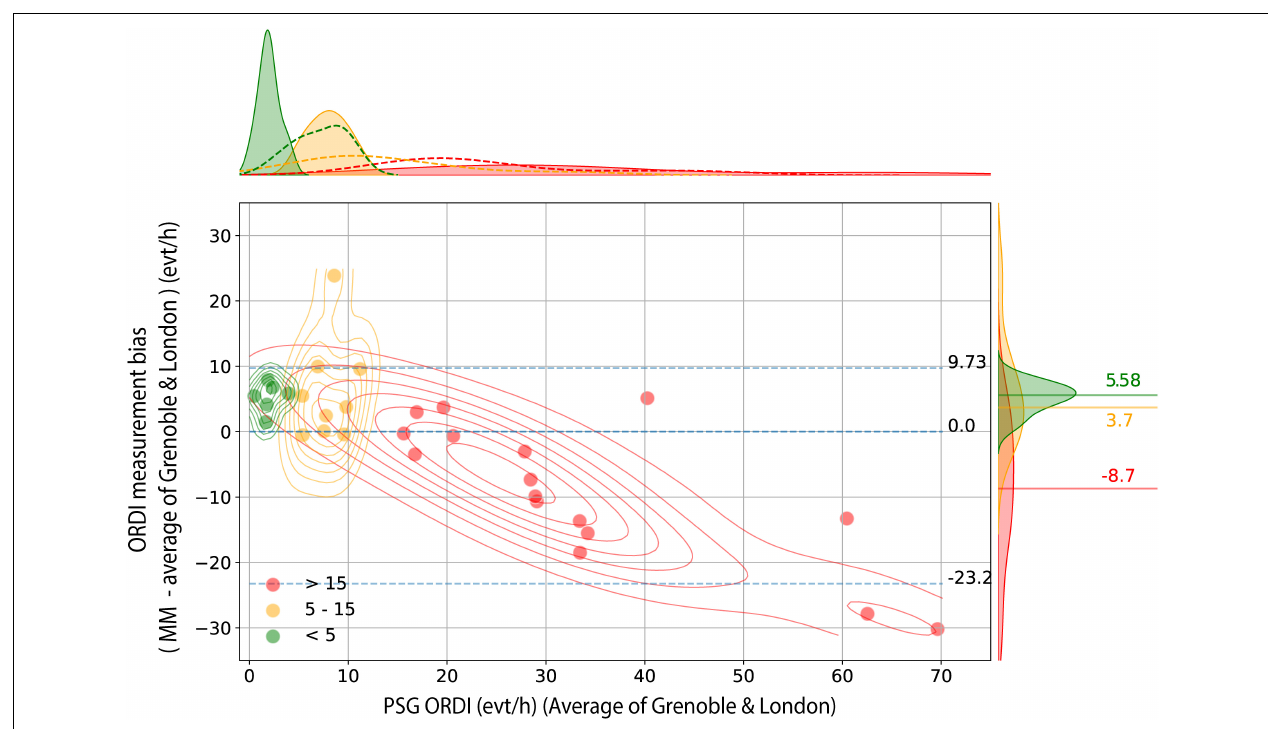
FIGURE 1 | Bland-Altman analysis for MM-ORDI versus average PSG-ORDI. Bland-Altman plot shows the disagreement between average PSG-ORDI and MM-ORDI (y axis) as a function of the average PSG ORDI (x axis), with individual cases stratified into three clinical groups. Bidimensional kernel density estimation plots are superimposed to show the joint distribution of measurement bias within each subgroup. The blue horizontal lines indicate the median, lower and upper bound (5th and 95th centiles) of the measurement bias in the whole sample. The distribution of the disagreement between the two methods, stratified by group, is shown on the right, with three horizontal lines indicating the median bias within each group. MM: mandibular movement; ORDI: obstructive respiratory disturbance index; PSG: